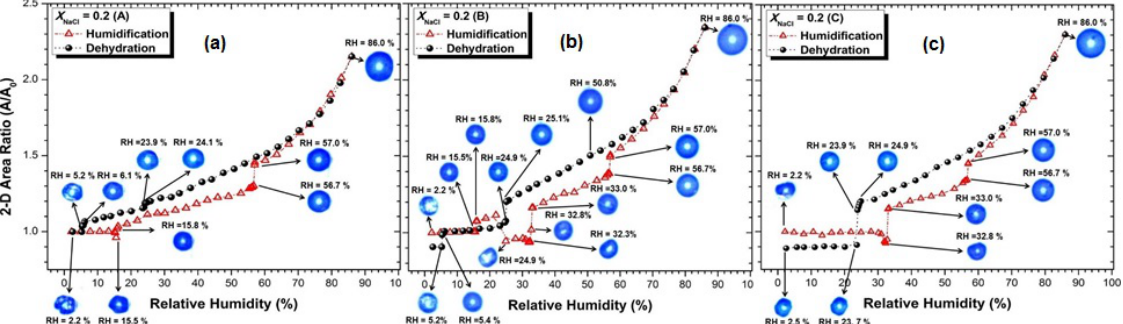
Figure 5. Plots of the 2-D area ratio ( A / A 0 ) of three representative particles with a composition of X NaCl = 0.2, showing different deli- quescence behaviors during the humidification process, as a function of RH. During the humidification process, (a) the “type A” particle shows two deliquescence transitions with MDRH of 15.8%, (b) the “type B” particle shows three deliquescence transitions as well as one efflorescence transition, and (c) the “type C” particle shows two deliquescence transitions with MDRH of 33.0%. During the dehydration process, type A and B particles show the second ERH of 5.2%, whereas the type C particle shows a second ERH of 23.7%. The recorded optical images of the particles/droplets along with the transition RHs during both humidification and dehydration processes are marked with